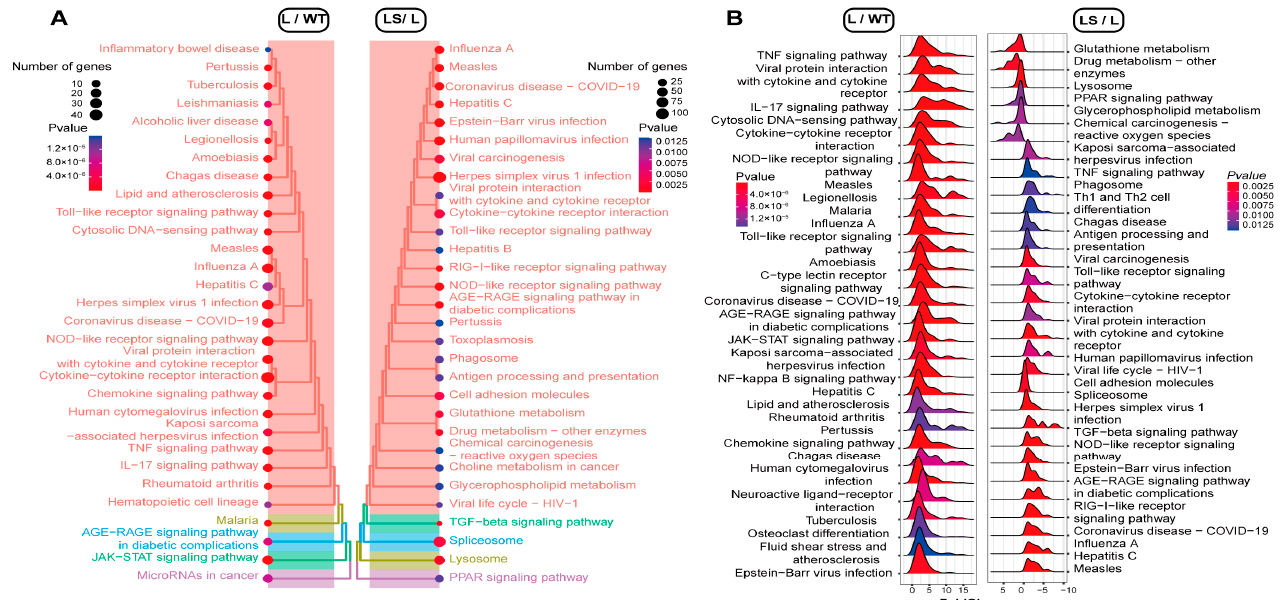
Figure 5. The gseaKEGG annotation. The p -value decreased from blue to red. ( A ) Treeplots of the different pathways among L, WT, and LS. The pathways were clustered by p -value. ( B ) Ridgeplots of the different pathways among L, WT, and LS. The up/down-regulation was marked with an x -axis (X > 0, up-regulated; X < 0, down-regulated).